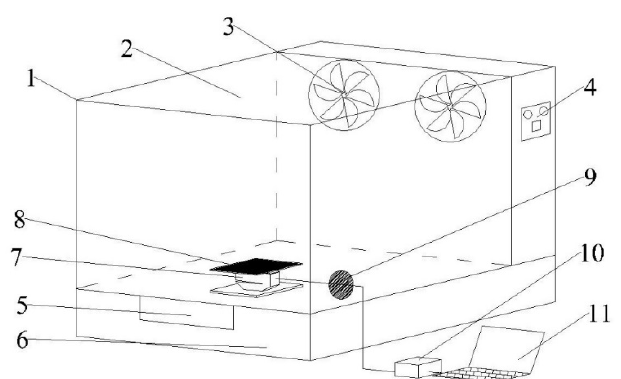
Figure 1. Schematic of the experimental device (1. environmental testing instrument; 2. drying